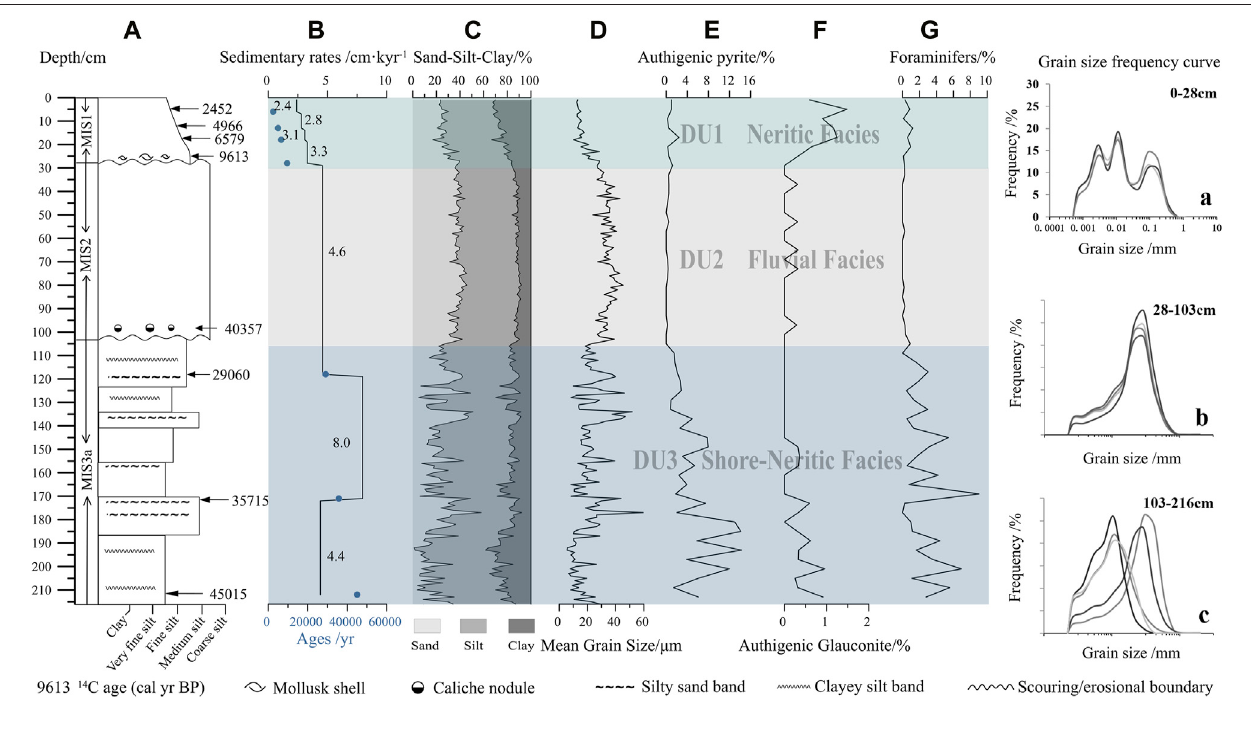
FIGURE 2 | Composite histogram of core H10 deposition (A – G, a – c)